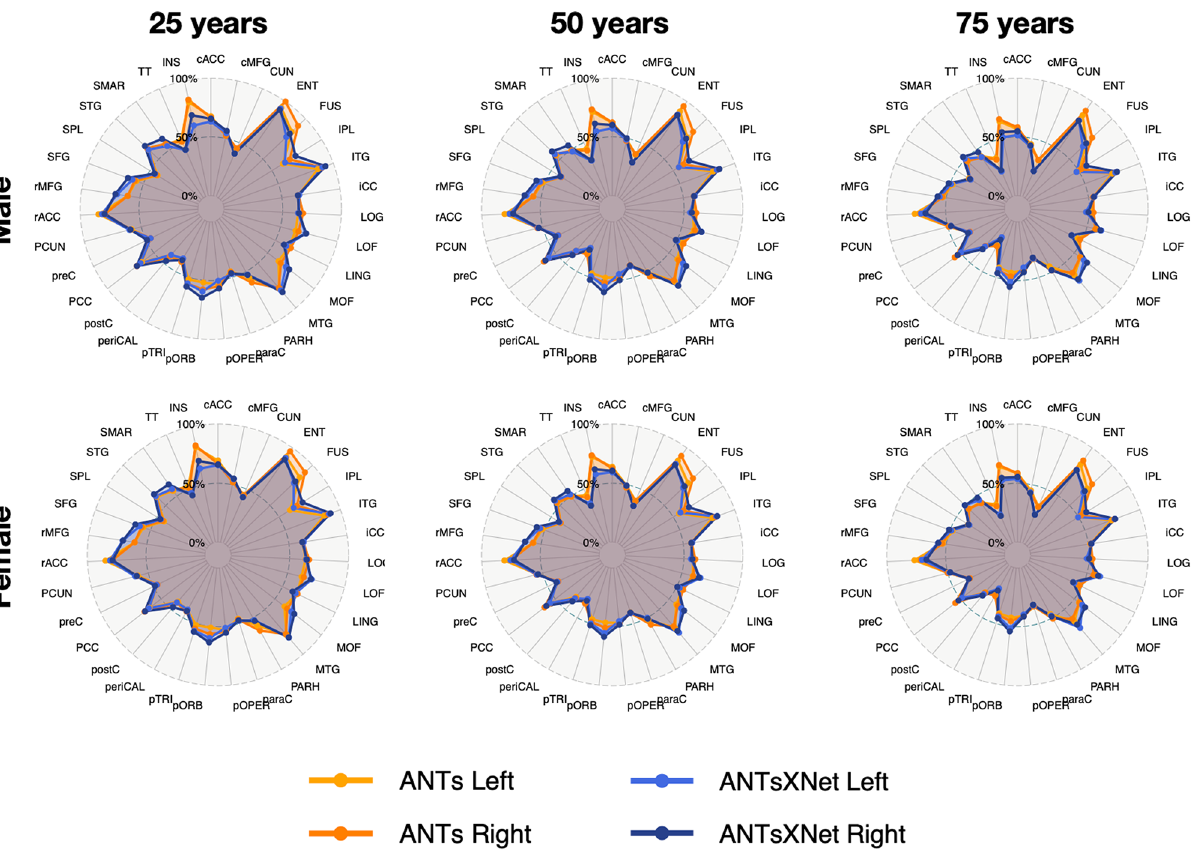
Figure 4. Radar plots enabling comparison of relative thickness values between the ANTs and ANTsXNet cortical thickness pipelines at three different ages sampling the life span. See Table 2 for region